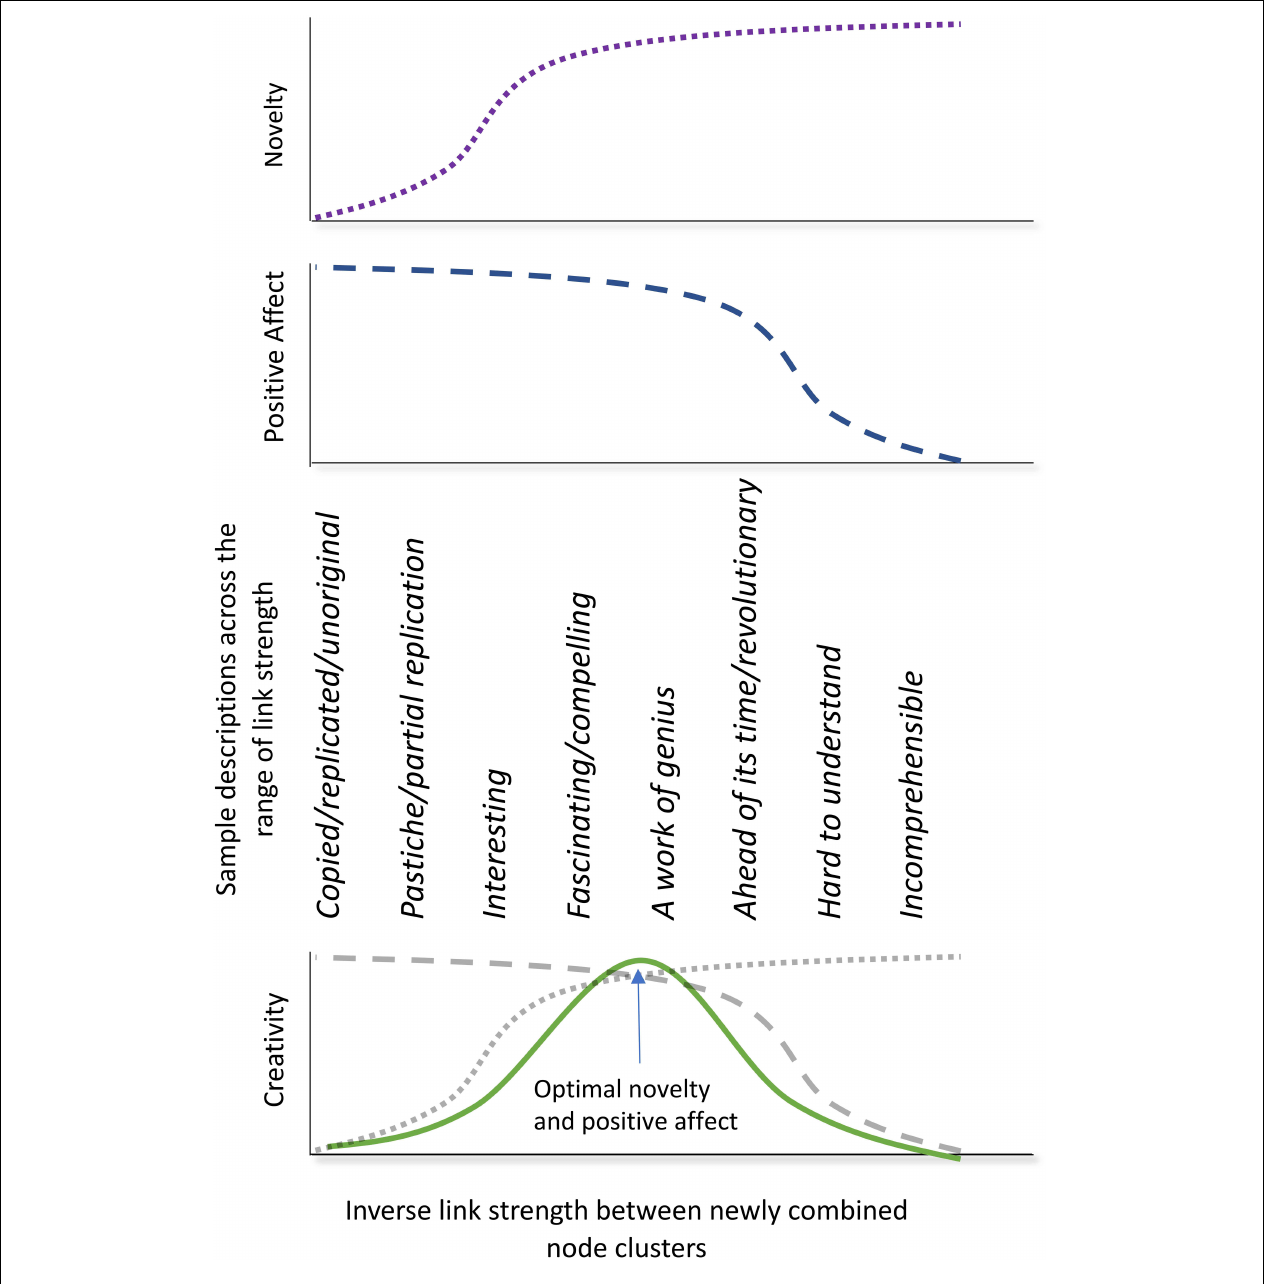
FIGURE 4 | Demonstration of the optimal novelty hypothesis—why novelty must be at an intermediate level rather than monotonic increasing to maximise creativity. The top curve indicates the implicit alternative (conventional) view that novelty increases monotonically as a function of decreasing link strength between transcombined node clusters. That is, more conceptually distant node clusters have a weaker link strength than node clusters that are conceptually more related. Below this is a plot of the activation strength decreasing as link strength decreases. Here activation is related to positive affect, and so we see less positive affect as more novelty is experienced. The bottom, green curve shows the schematic superposition of these two curves, which gives rise to a maximal level of creativity, where creativity is defined in terms of optimal novelty and positive affect. Note that positive affect is proposed as a better indicator than “usefulness” when assessing creative works, as explained in the body